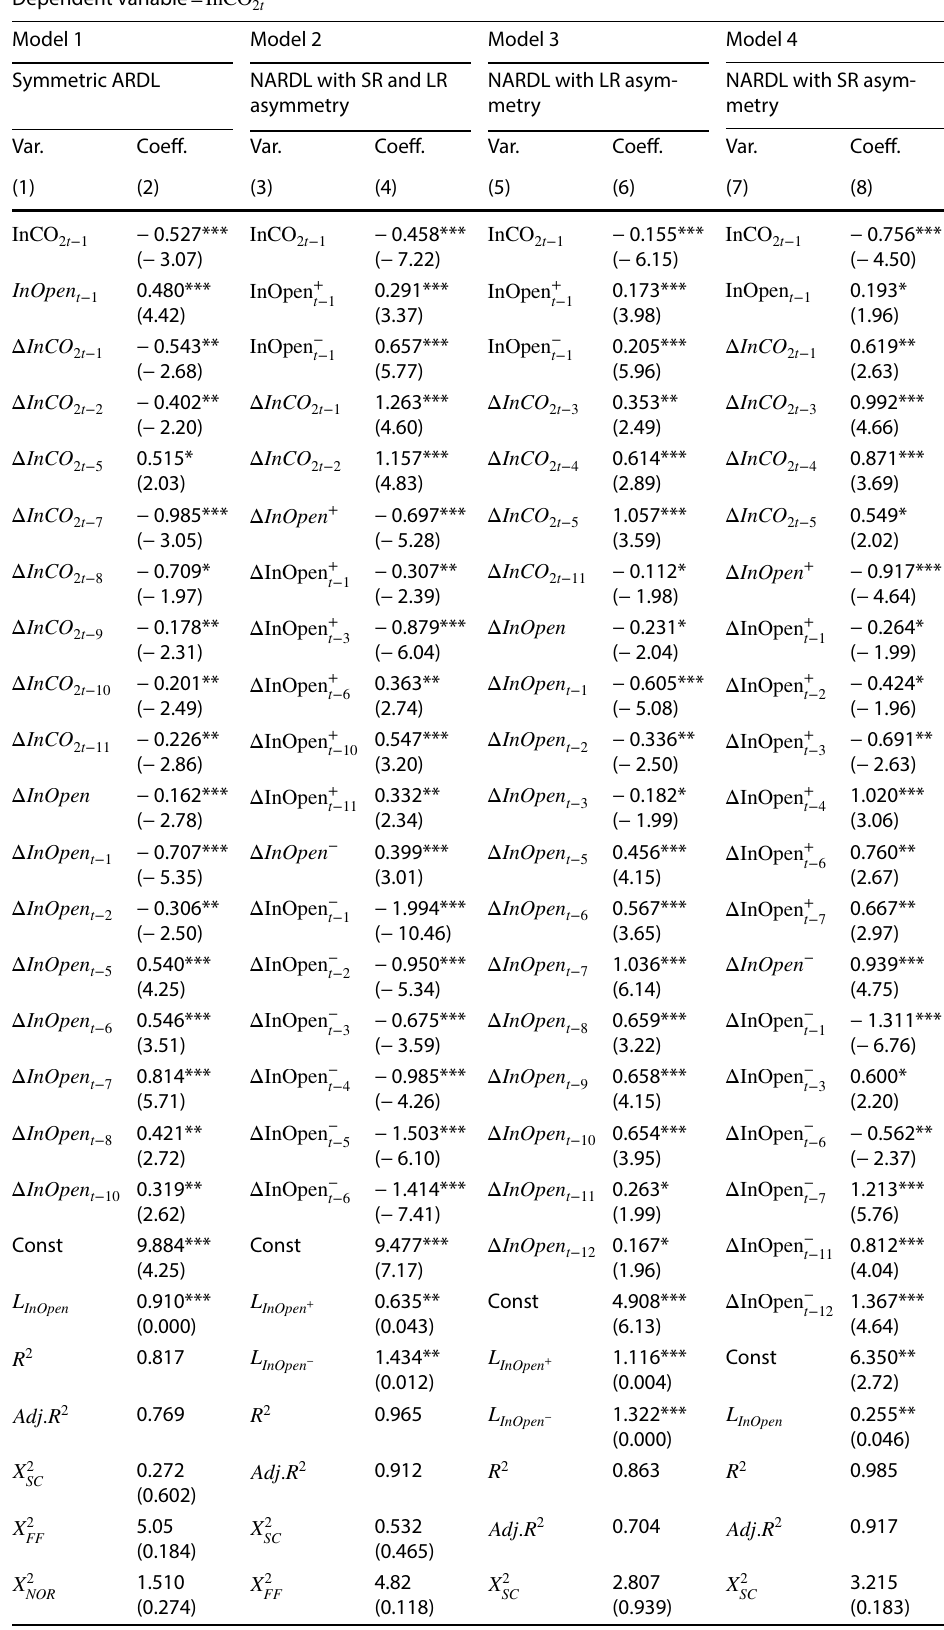
Table 9 Full-information estimates of both symmetric ARDL and nonlinear ARDL (NARDL) models in